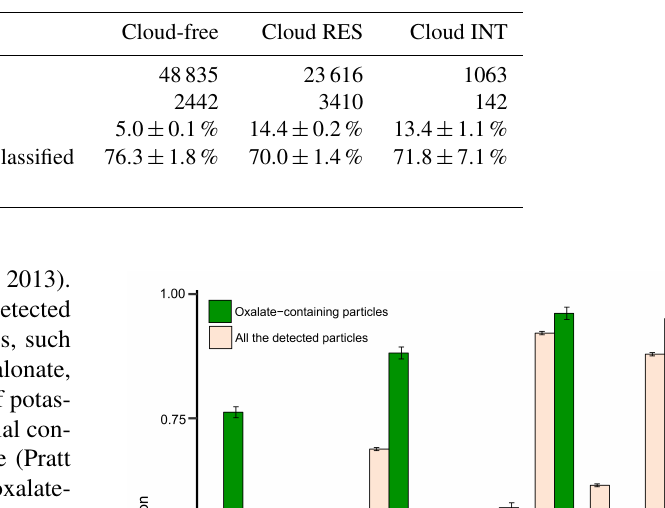
Table 1. The number and number fraction (Nf) of oxalate-containing particles in the all the detected cloud-free, cloud RES, and cloud INT particles.